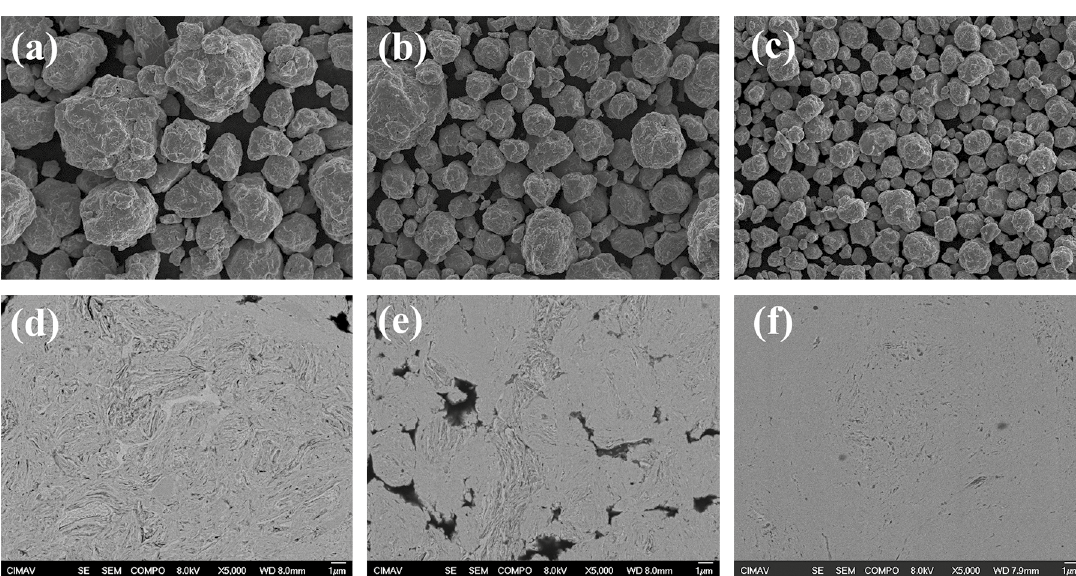
Figure 1: SEM micrographs of the elemental powders morphology.